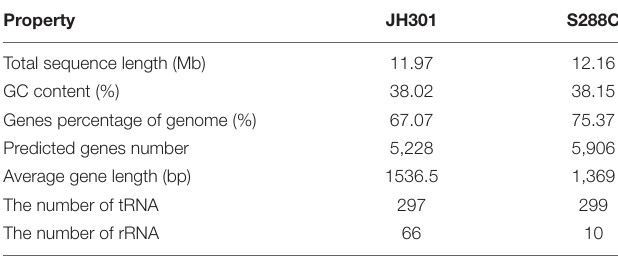
TABLE 4 | Whole genome sequencing and annotation results.